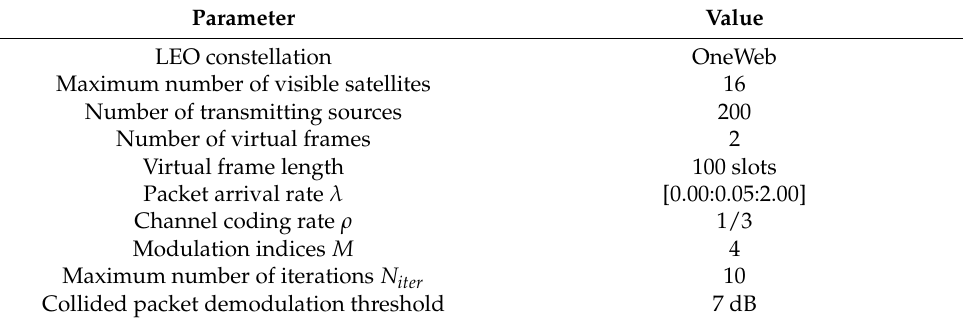
Table 1. Simulation